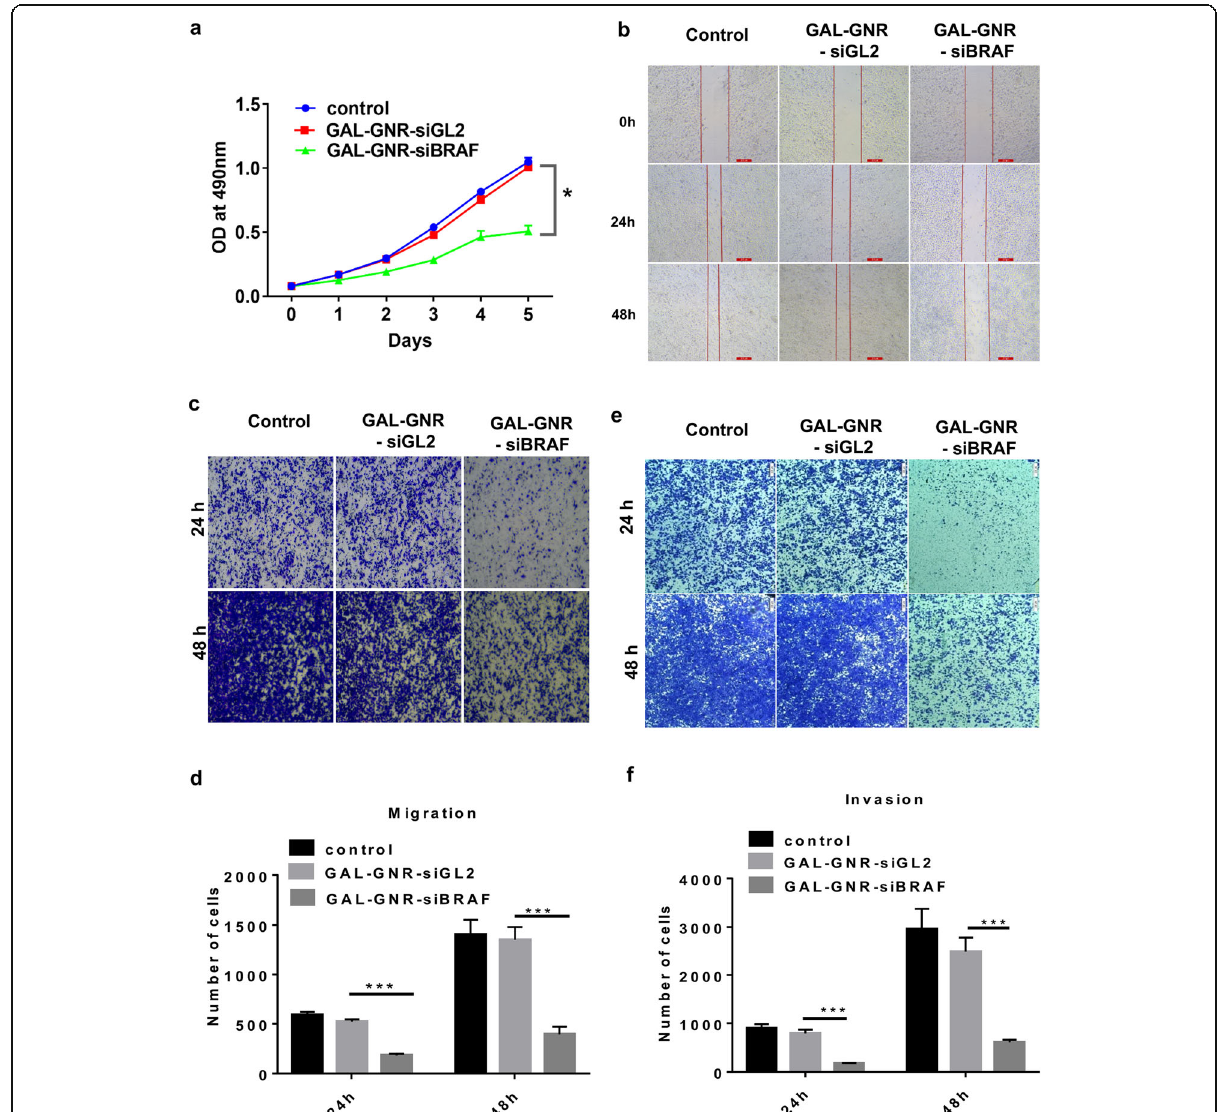
Fig. 5 The impact of silencing BRAF gene on Hepa1-6 cells by GAL-GNR-siBRAF. a Proliferation of Hepa1-6 Cells. Hepa1-6 cells were transfected with GAL-GNR-siBRAF, GAL-GNR-siGL2, or PBS, and the cell proliferation was measured by MTT assay ( n = 5). The error bar represents the standard deviation of three experiments (* p < 0.05). b Scratch test of Hepa1-6 cells. Hepa1-6 cells were transfected for 24h as described above and then scraped with a 10 μ L tip. The cell scratch images were taken at different time points (scale bar = 200 μ m). c and e Migration and invasion of Hepa1-6 cells. Hepa1-6 cells were transfected for 24h as described above. Cell migration and invasion ability was determined by transwell assay, and imagines were taken at different time points (scale bar = 200 μ m). d and f Columnar statistical analysis of cell migration and invasive capacity (*** p <